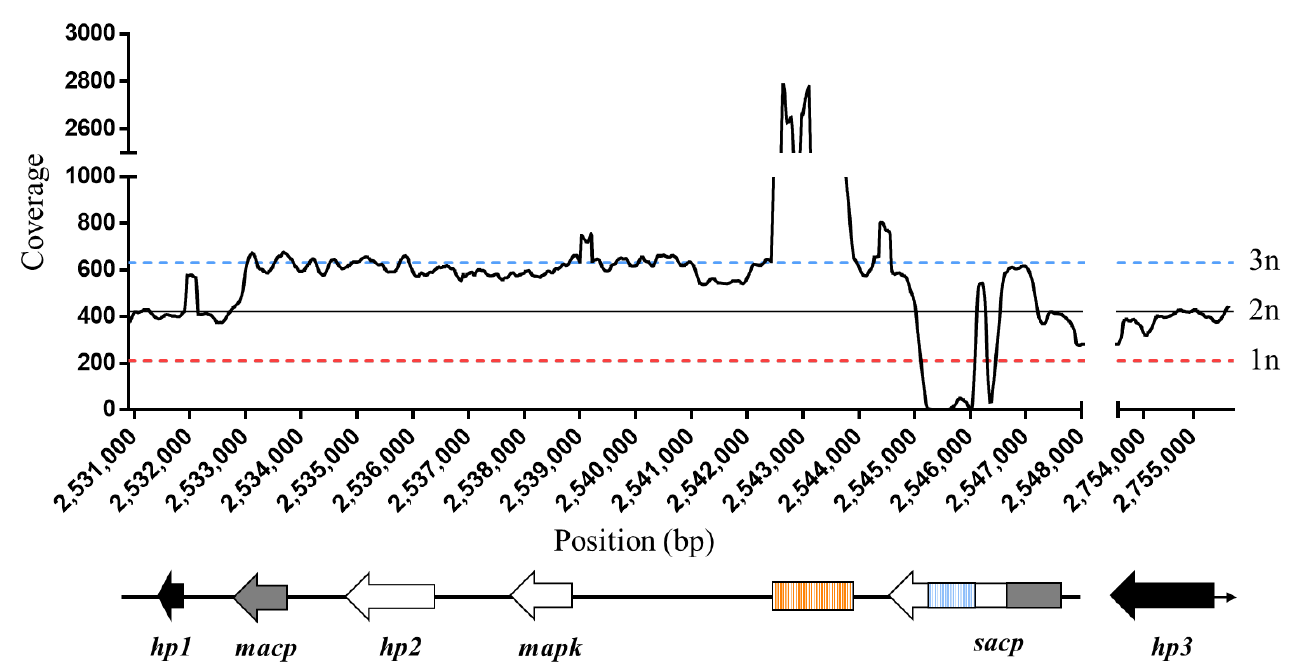
Figure 1. sacp gene copy number in the L. donovani 1S2D used in this study. The read depth coverage by base pair was determined using the module bedtools coverage. An analysis was performed between positions 2,530,900 and 2,548,000 and between positions 2,753,500 and 2,755,800 of chromosome 36 spanning the following genes: hypothetical protein 1 ( hp1 , LdCL_360075600), the membrane- bound acid phosphatase ( macp , LdCL_360075700), the hypothetical protein 2 ( hp2 , LdCL_360075800), the mitogen-activated protein kinase ( mapk , LdCL_360075900), the secreted acid phosphatase ( sacp , LdCL_360076000) and hypothetical protein 3 ( hp3 , LdCL_360080400). The schematic representation (bottom) shows episomal genes in white and non-episomal genes in black. The portion of sacp that is genetically nearly identical to macp is shown in grey. The two genetically different regions with repetitive GC-rich sequences are striped orange and striped blue. The coverage graph (top) shows the sliding window read depth coverage as a function of position in base pairs. The average coverage for diploid genes (2n ≈ 400 × ) is the solid black line, the average coverage for haploid genes (1n ≈ 200 × ) is the dotted red line and the average coverage for triploid genes (3n ≈ 600 × ) is the dotted blue line. Note: the axis was split between 2,548,000 and 2,754,000 to condense the cluster of sacp genes present in the LdSL-CL reference genome to be more representative of the L. donovani 1S2D